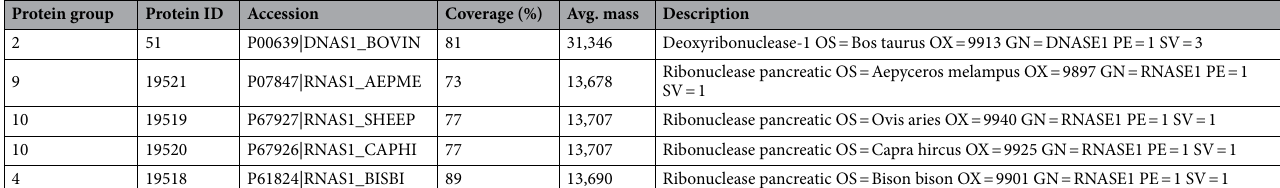
Coverage (%) Avg. mass Description